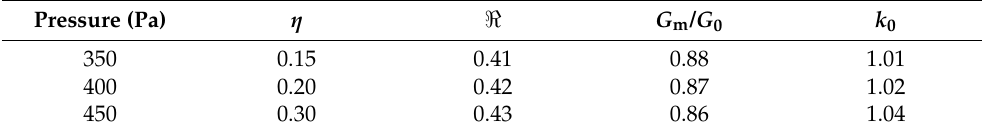
Table 1. Ne 20 :Ne 22 = 1:1, λ = 632.8 nm; calculation parameters under different inflation pressures. Pressure (Pa)